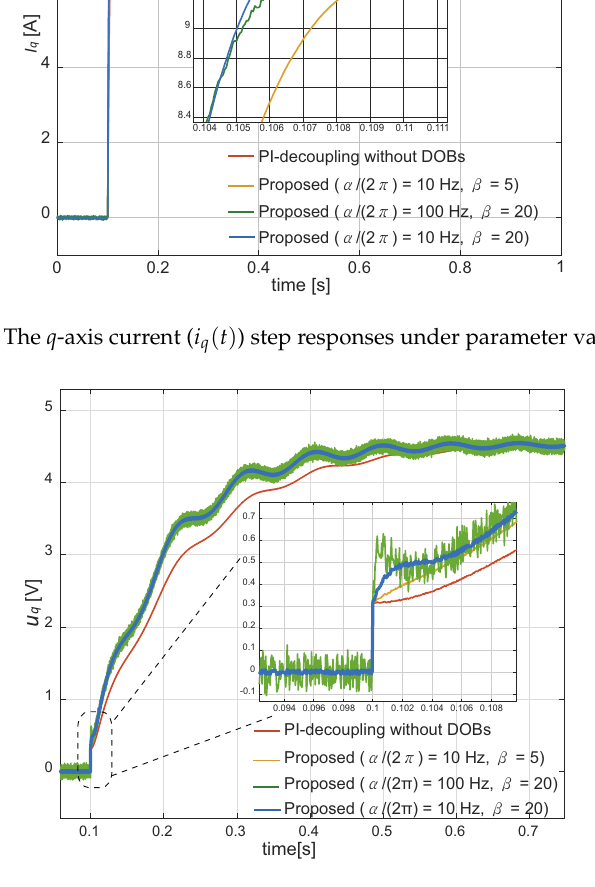
Figure 7. The q -axis control input ( u q ( t ) ) under parameter variations.